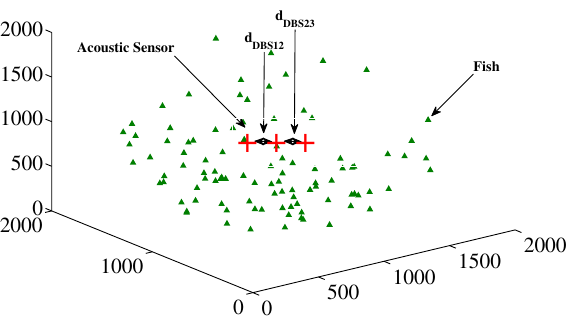
Figure 1. A uniform random distribution of fish and mammals with three equally spaced acoustic sensors using ASL scheme. Here, the axes units are in meter. We used MATLAB R2010a to achieve this figure.